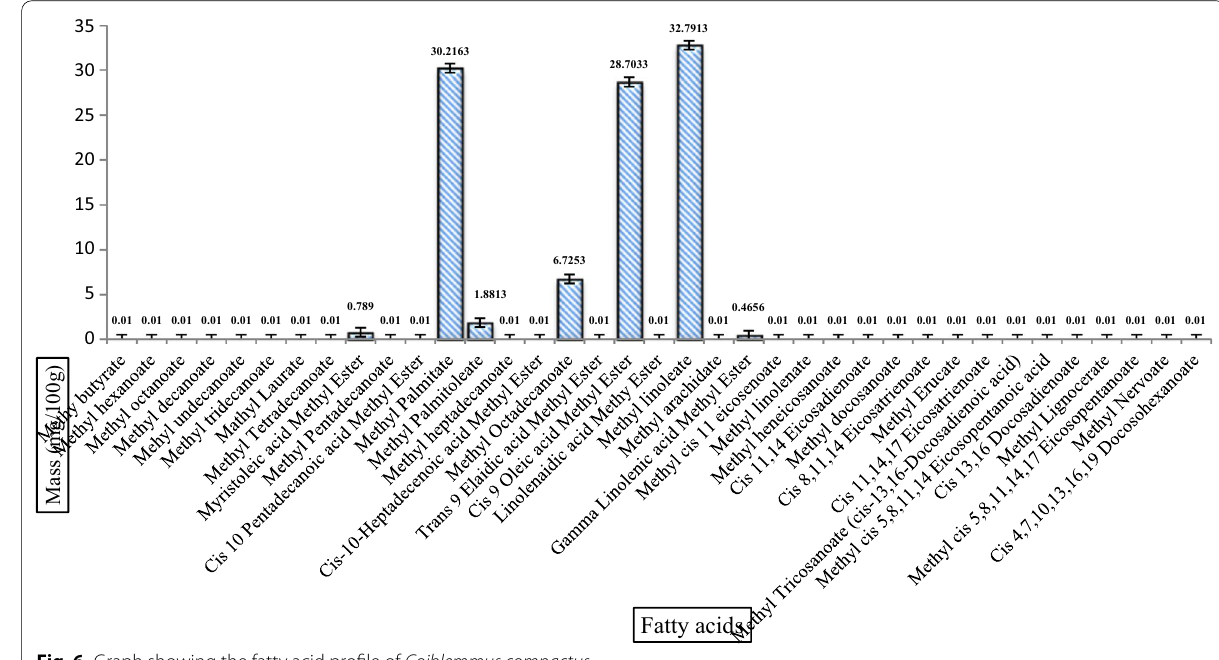
Fig. 6 Graph showing the fatty acid profile of Coiblemmus